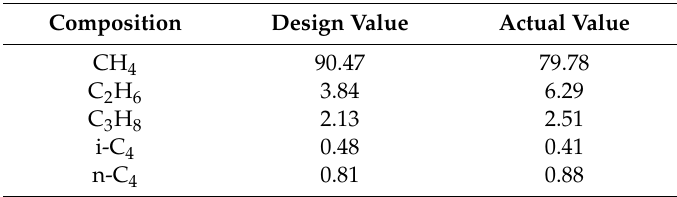
Table 1. Natural gas component.